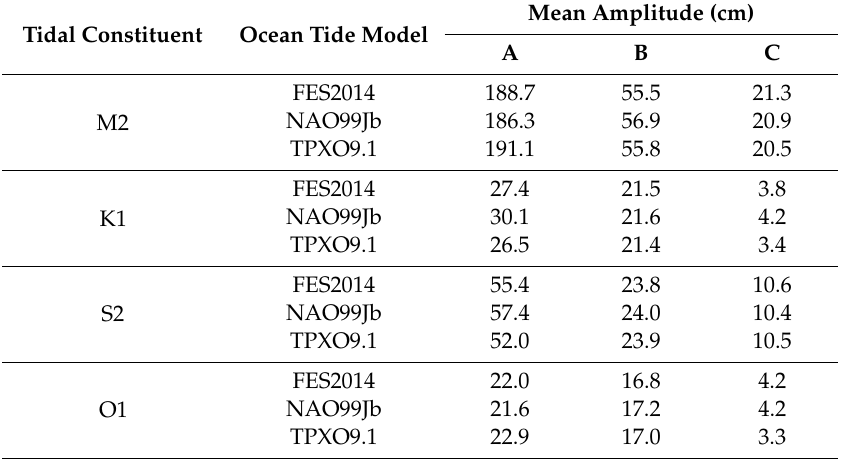
Table A10. Averaged interpolated amplitudes of tidal constituents at open boundaries. Tidal Constituent Ocean Tide Model